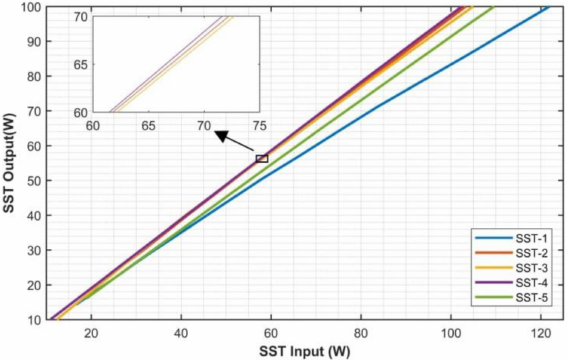
Figure 5. Output vs. input characteristics of SSTs.